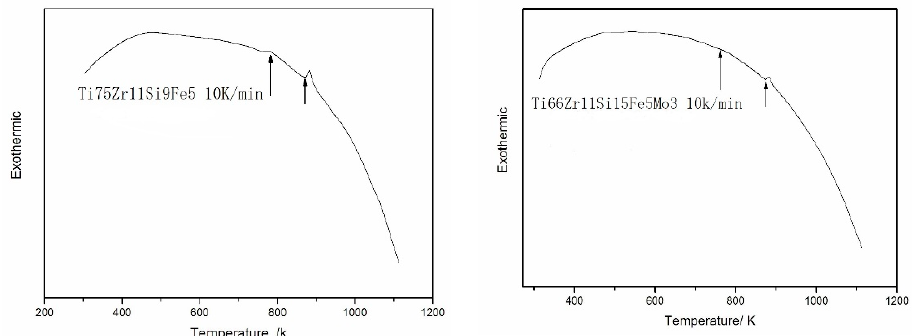
Figure 4. DSC thermograms of amorphous alloys of both Ti75Zr11Si9Fe5 (At %) and